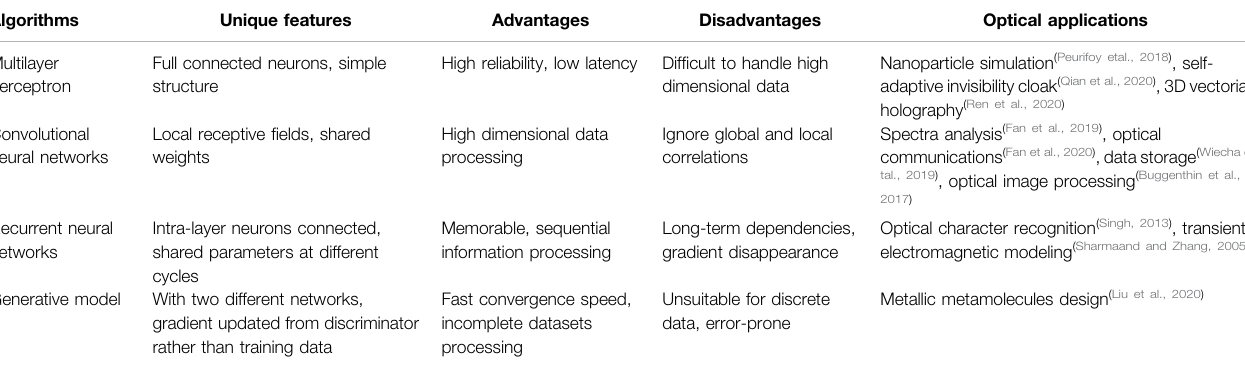
TABLE 1 | Comparison of deep learning